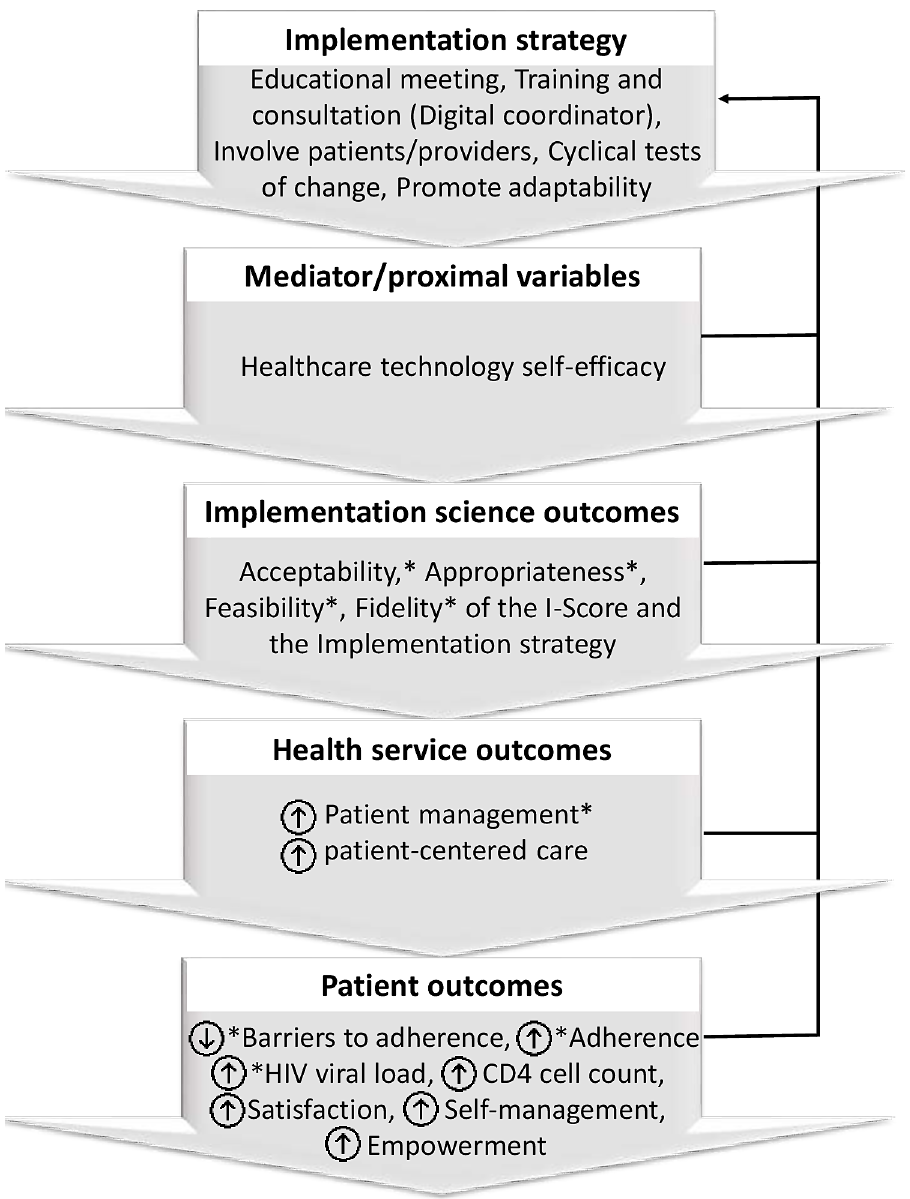
Fig 2. Relationship between the I-Score implementation strategy and study outcomes. Asterisks indicate outcomes for which data will be collected as a part of this pilot